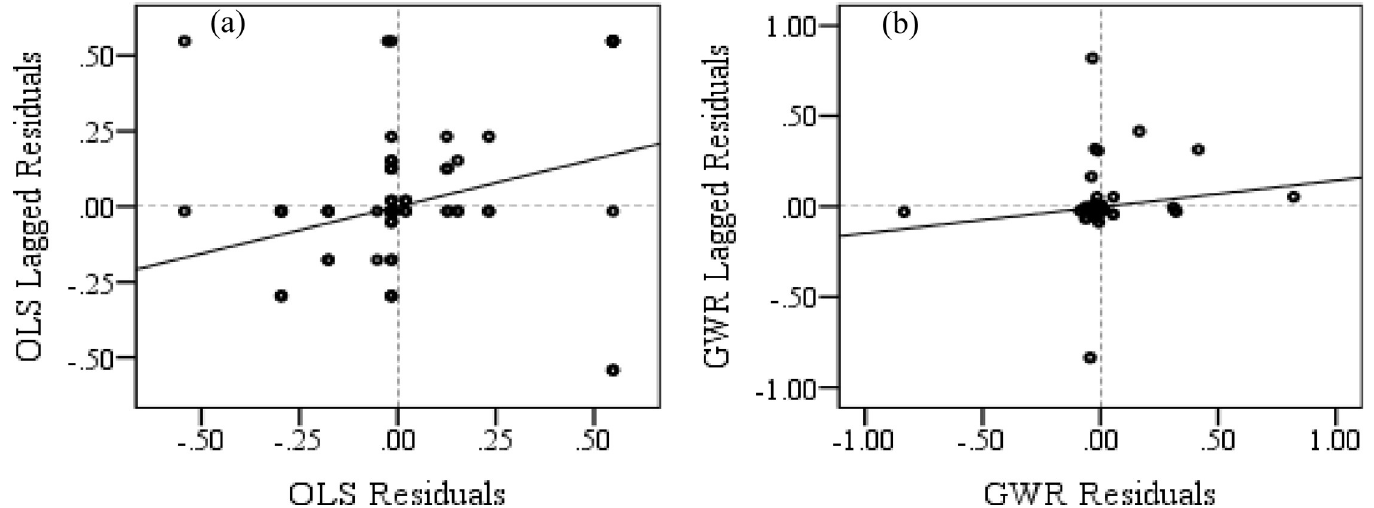
Fig 7. Moran scatter plots for (a) OLS and (b) GWR residuals.